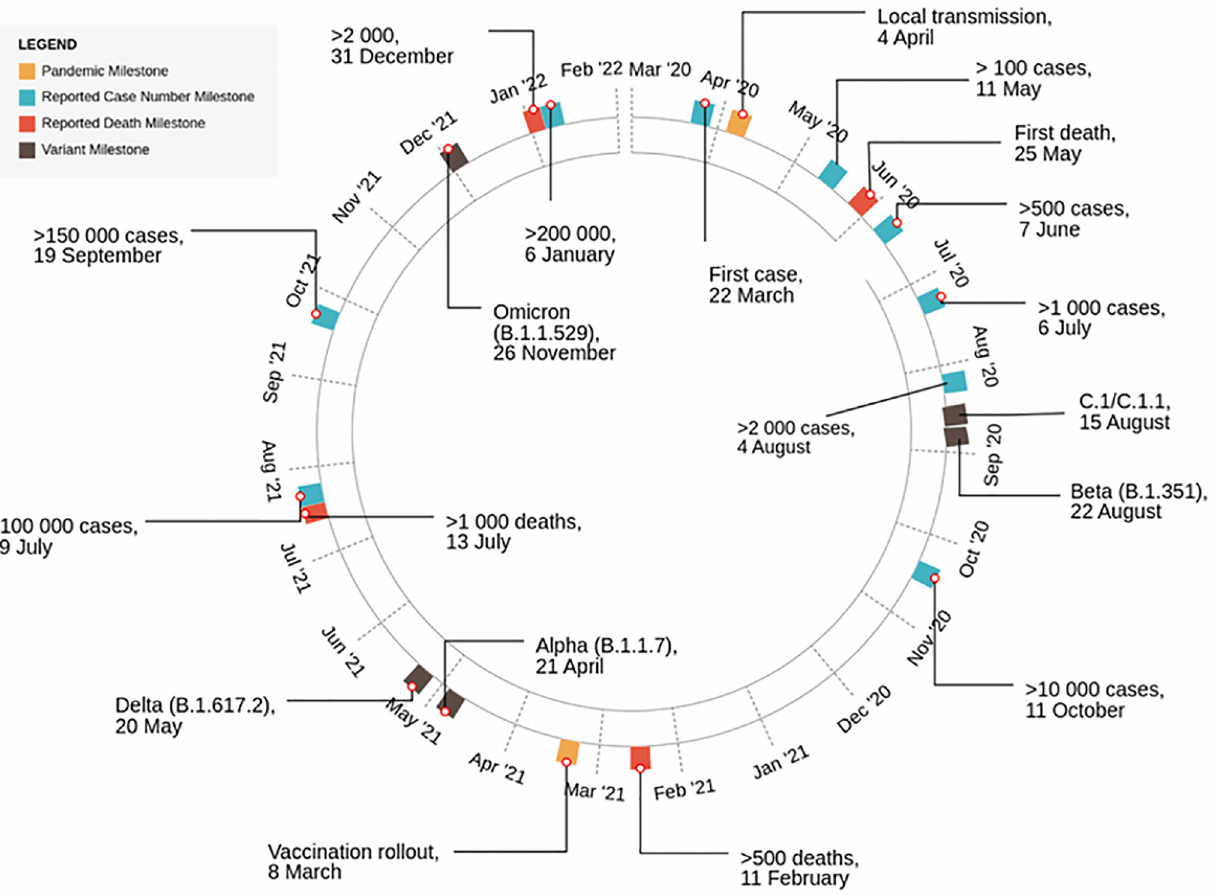
Fig 1. Schematic representation of the progression and milestones occurring during the COVID-19 pandemic in Mozambique (March 2020- April 2022). The number of reported COVID-19 cases milestones were illustrated in blue, the total deaths milestones are illustrated in red, the first detection of new variants are illustrated in black, and other key milestones such as local transmission and vaccination rollout are illustrated in